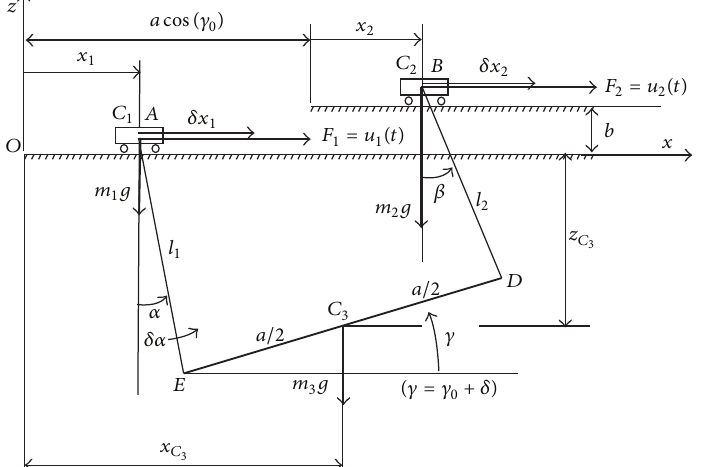
Figure 6: The computational scheme for transportation of heavy cross-beam DE by two guided bridge cranes 𝐴 and 𝐵 with applied control forces to carts 𝐴 and 𝐵 with forces’ magnitudes 𝐹 1 = 𝑢 1 (𝑡) and 𝐹 2 = 𝑢 2 (𝑡) .